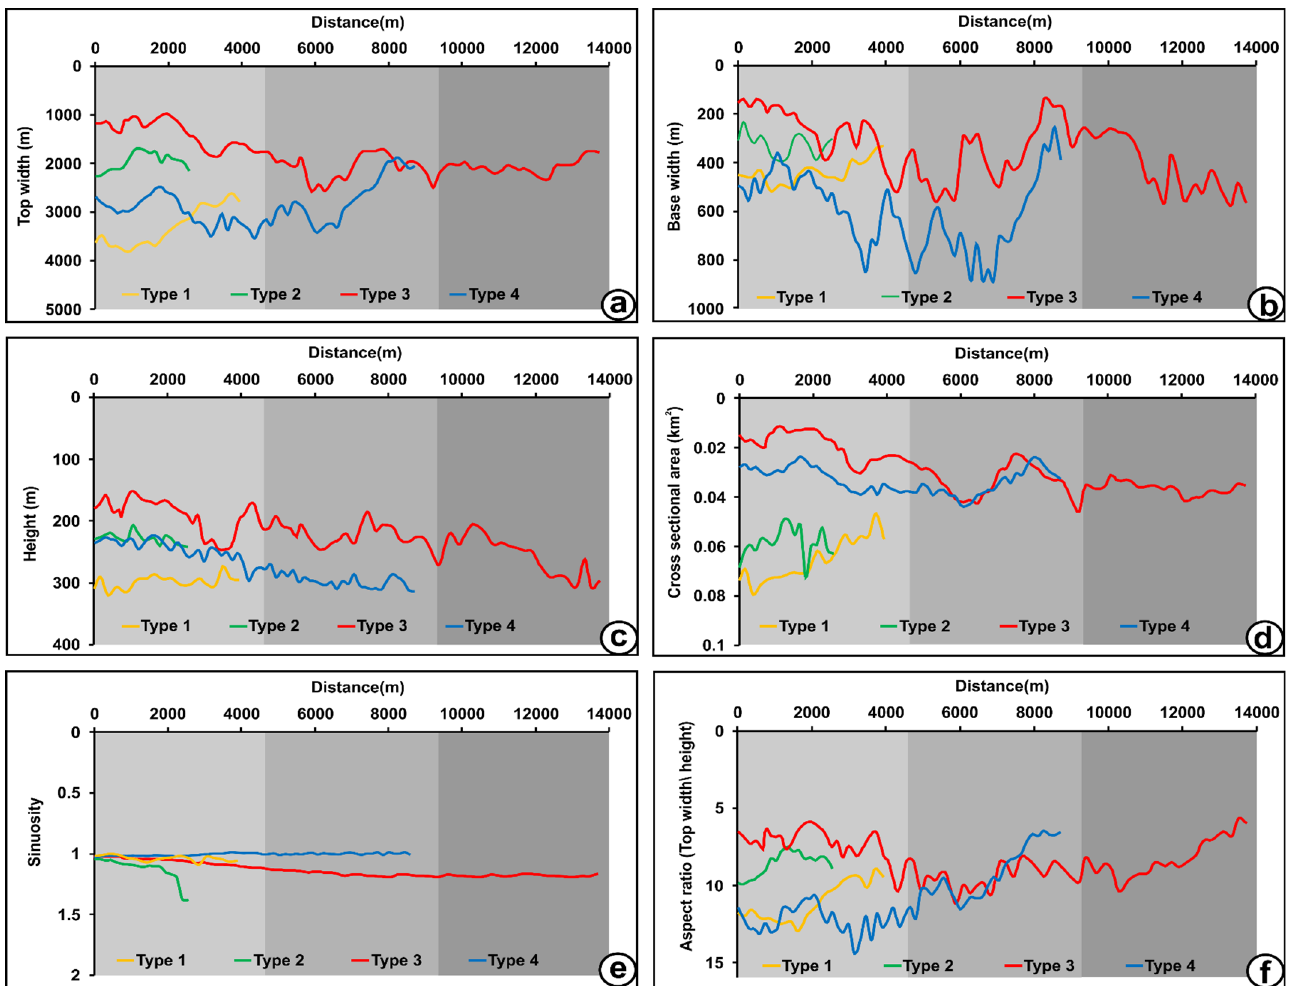
Figure 8. Morphological analysis of four different types of channels complexes in the western (light grey), middle (medium grey), and eastern (grey) areas. ( a ) Top width vs. distance, ( b ) Base width vs. distance, ( c ) Height vs. distance, ( d ) Cross-sectional area vs. distance, ( e ) Sinuosity vs. distance, ( f ) Aspect ratio vs distance. Table 1. Average morphometry data of four channel complexes in the study area.